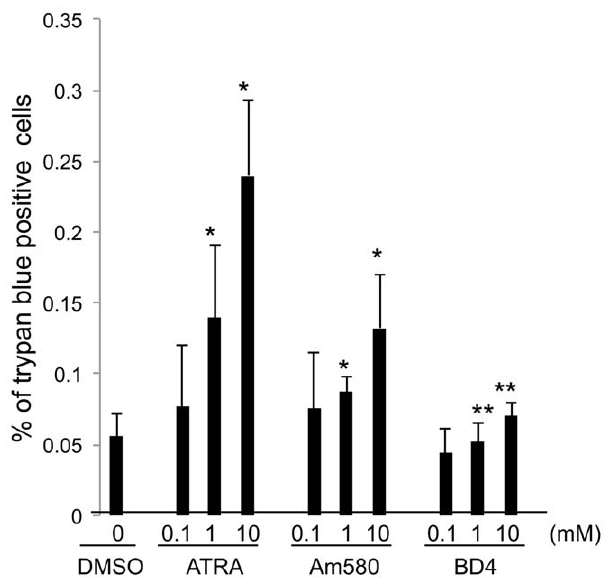
Figure 4. Cell toxicity assay. Mouse podocytes cultured at 37 u C for 10 days and then treated with ATRA, Am580, or BD4 at the different concentrations for 24 hours in serum free medium. Cell death was quantified by trypan blue staining, n=6, *p , 0.01 compared to cells treated with DMSO, **p , 0.05 compared to cells treated with either ATRA or Am580 at corresponding